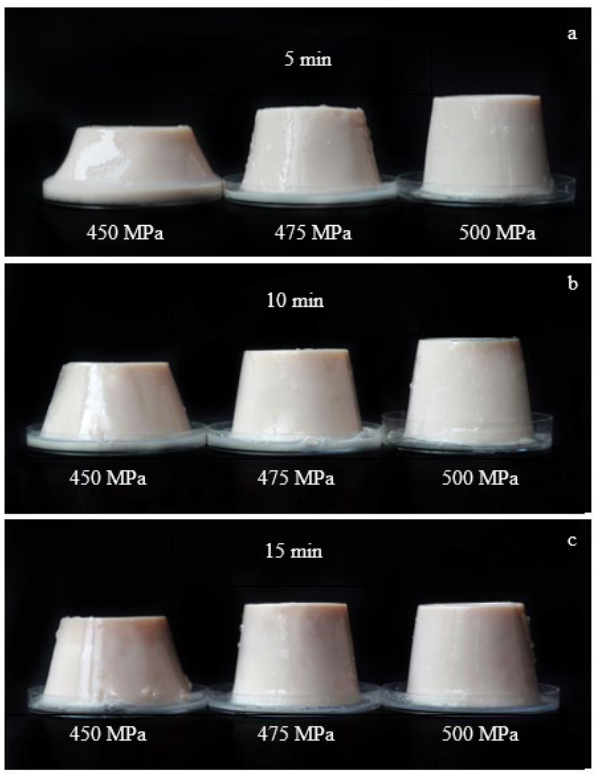
Figure 1. Effect of high-pressure on appearance of strawberry-flavoured egg-white pudding for different holding times: 5 min ( a ), 10 min ( b ), and 15 min ( c ).